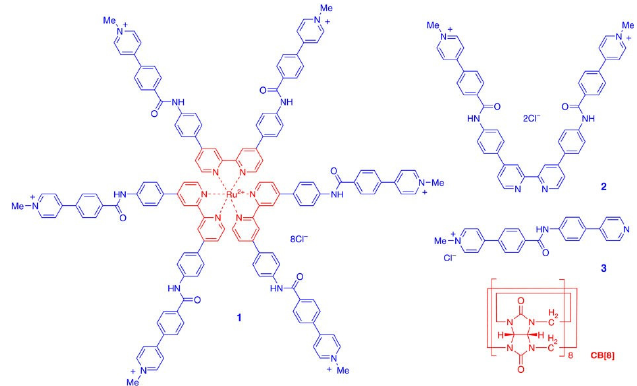
Figure 14. The building blocks used for the synthesis of the metal-cored supramolecular organic framework, SMOF-1. Reprinted with permission from [155]. Copyright (2016), Springer Nature.